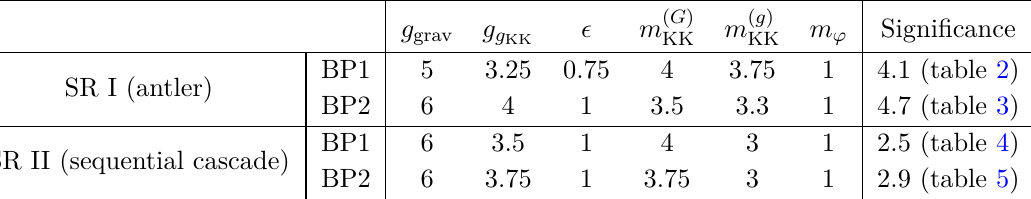
Table 1 . A summary table of our benchmark points that are investigated in section 5, with the mass parameters given in TeV. The antler decay and the sequential cascade decay are dominant in SR I and SR II, respectively. All the benchmark points listed here are safe from the existing bounds (see also figure 5). In the last column, we preview the expected statistical significance, which is defined by the number of signal events divided by the square-root of the number of background events, at the LHC 14 TeV with a luminosity of 3,000 fb − 1 (see section 5 for more details).